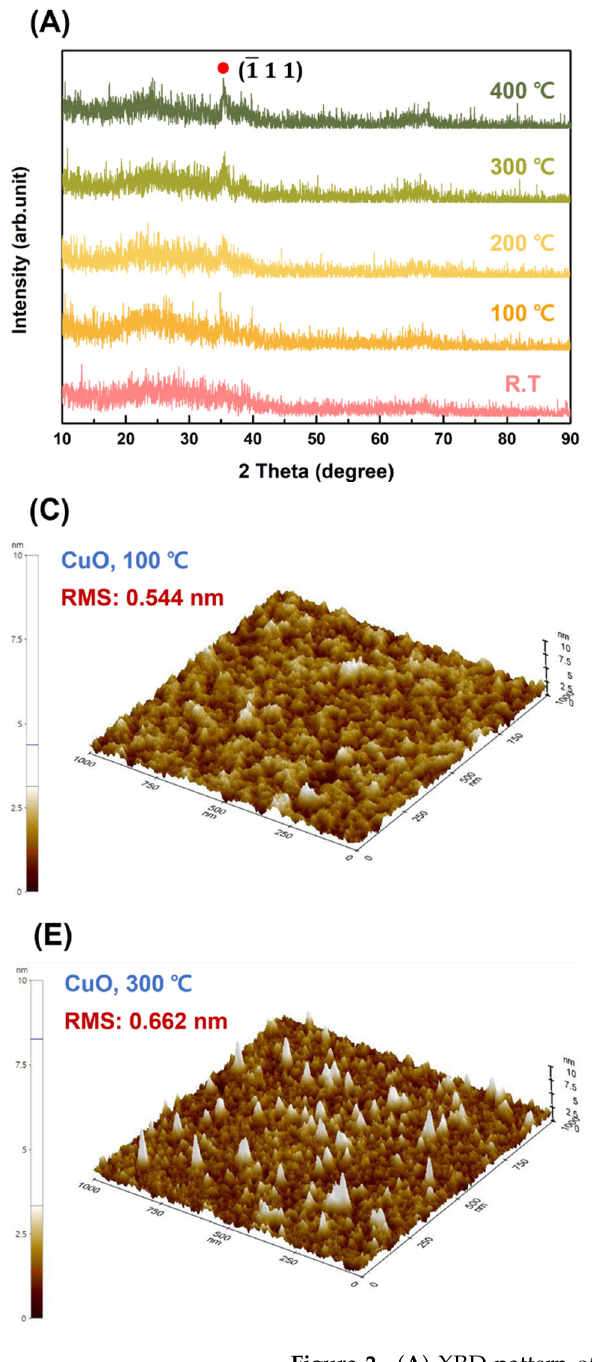
Figure 2. ( A ) XRD pattern of as-fabricated CuO film and films postannealed from 100–400 °C; ( B ) AFM images of surface morphology of as-fabricated CuO film and films postannealed at ( C ) 100 °C; ( D ) 200 °C; ( E ) 300 °C; ( F ) 400 °C, deposited on the glass substrate.